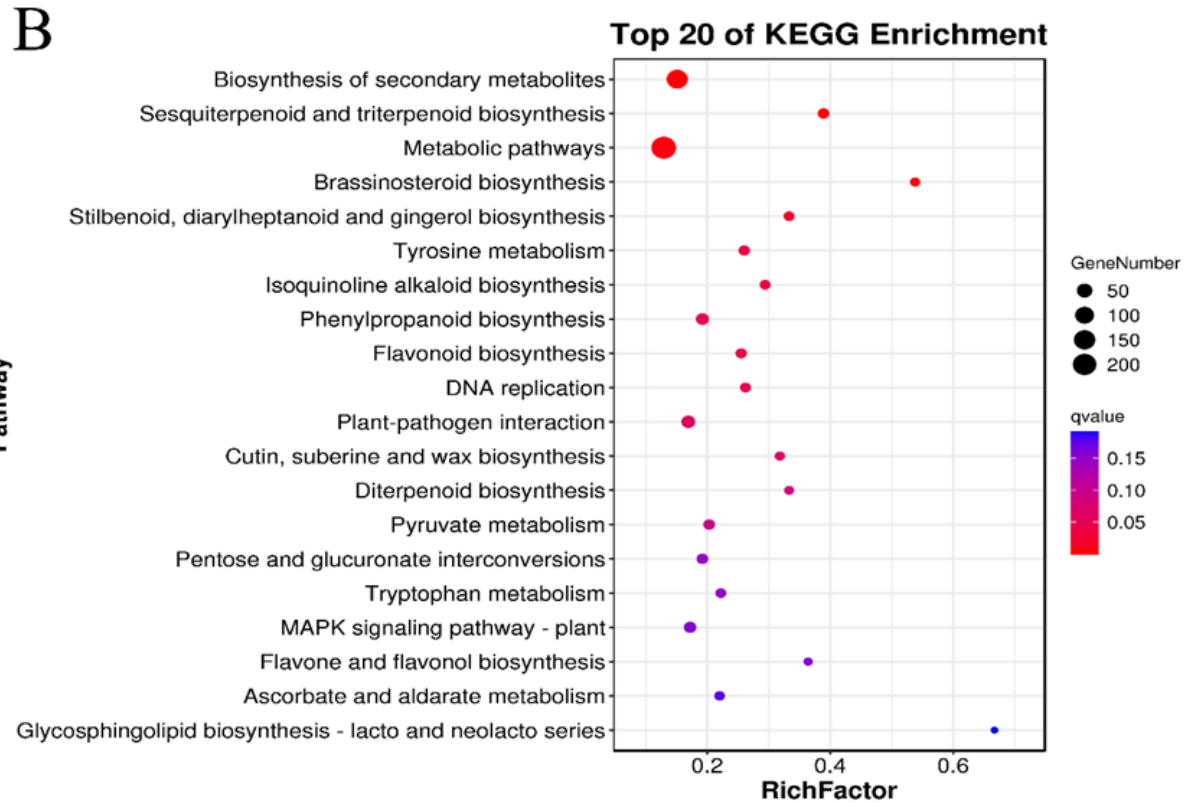
Figure 5. Enrichment Analysis of Differentially Expressed Genes (DEGs) Involved in the Metabolic Pathways Altered in Treated Leaves and Stems via the KEGG Database. ( A , B ), two charts show enriched metabolisms altered in treated leaves (C-Y) ( A ) and stems (C-J) ( B ). The KEGG enrichment bubble diagrams indicate that the top 20 enriched metabolisms with the smallest Q value. The ordinate includes plant metabolisms. The abscissa is the enrichment factor (the number of DEGs in the pathway divided by all the numbers in the pathway). Bubble size indicates the quantity. The color code from blue to red indicates the trend from the biggest to smallest Q values. KEGG, Kyoto Encyclopedia of Genes and Genomes.